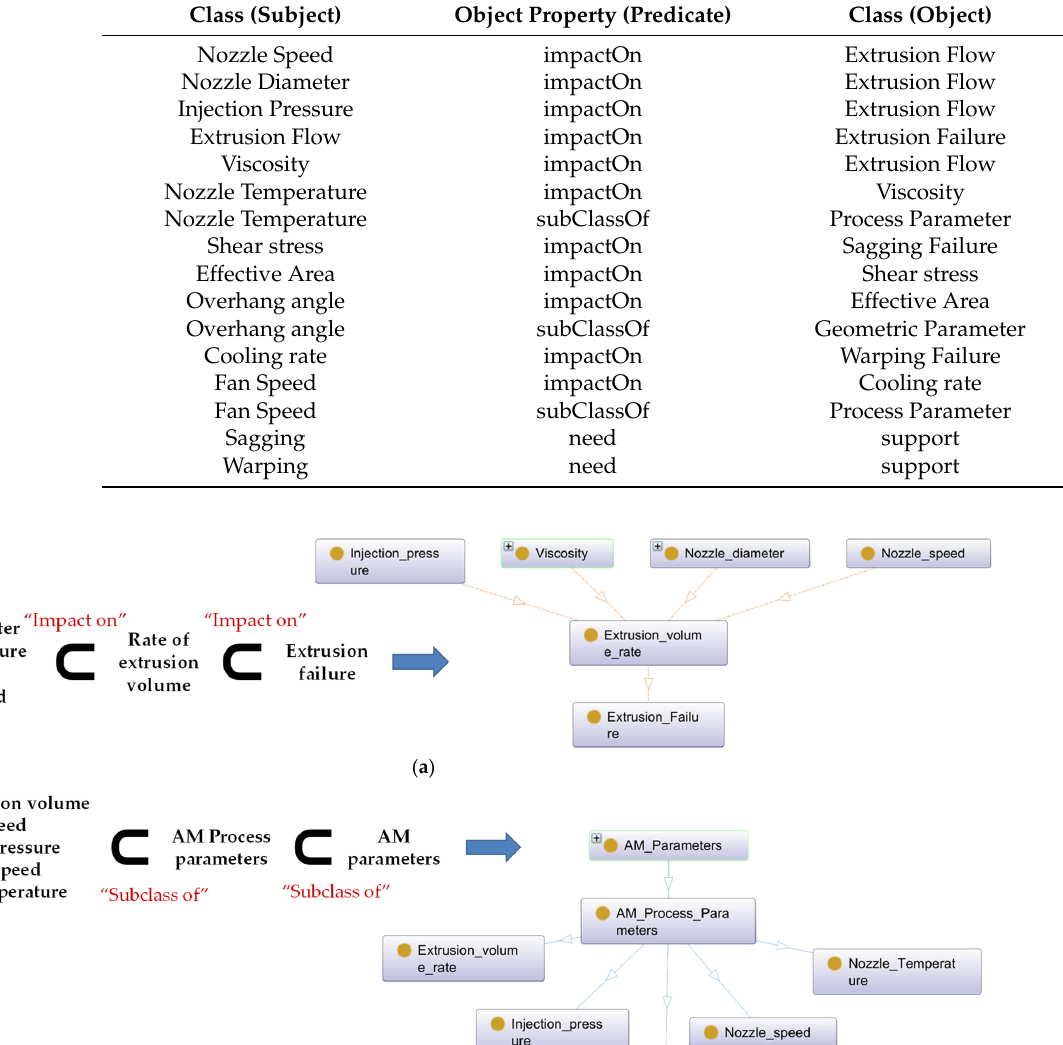
Table 2. Example for elements of knowledge-base.